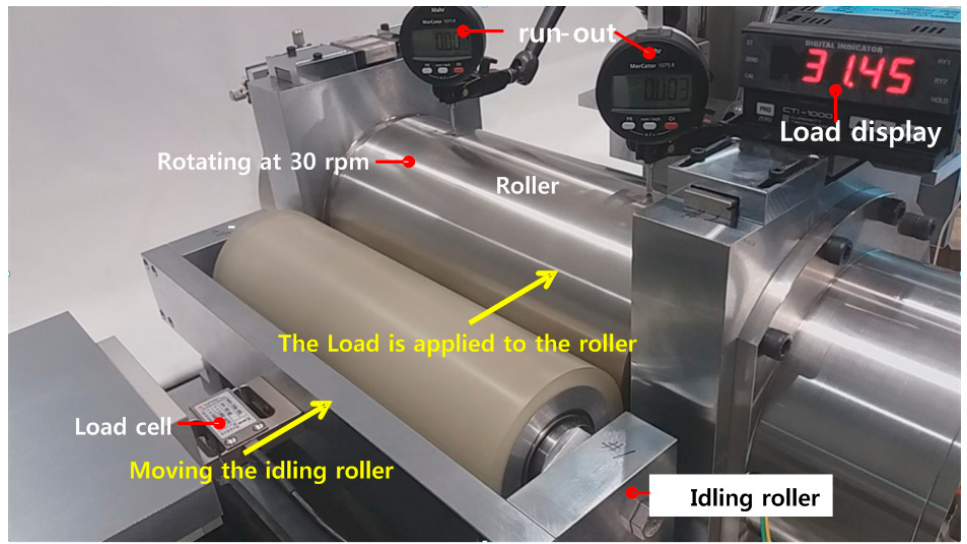
Figure 7. Vibration measurement test of precision roller for printing with magnetic bearings depending on load. Supplimentary material, Video S1 is provided for this test.